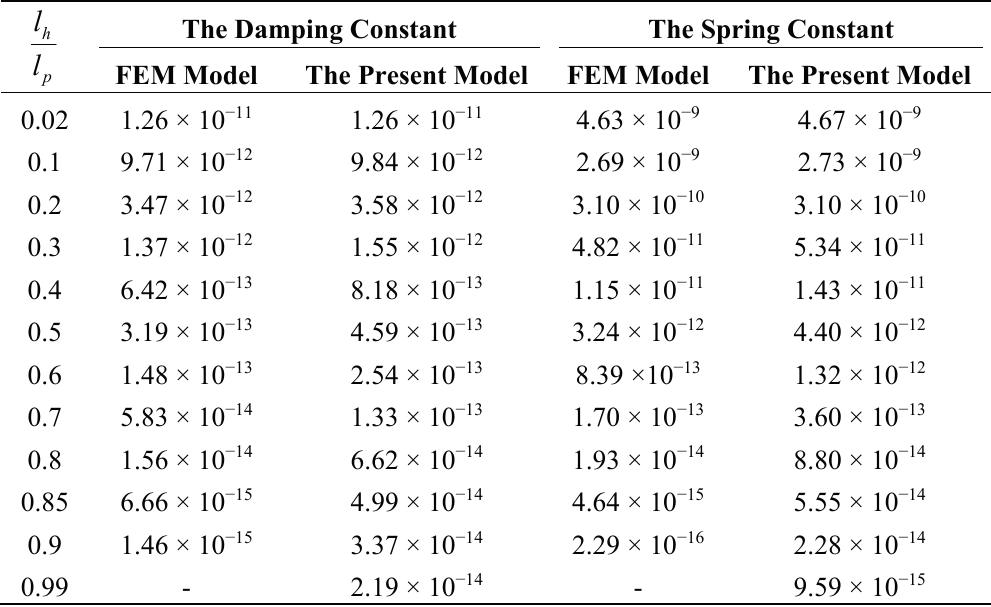
Table 5. The damping and spring constants obtained by the ANSYS model and the presnt model for the torsion microplate (Type